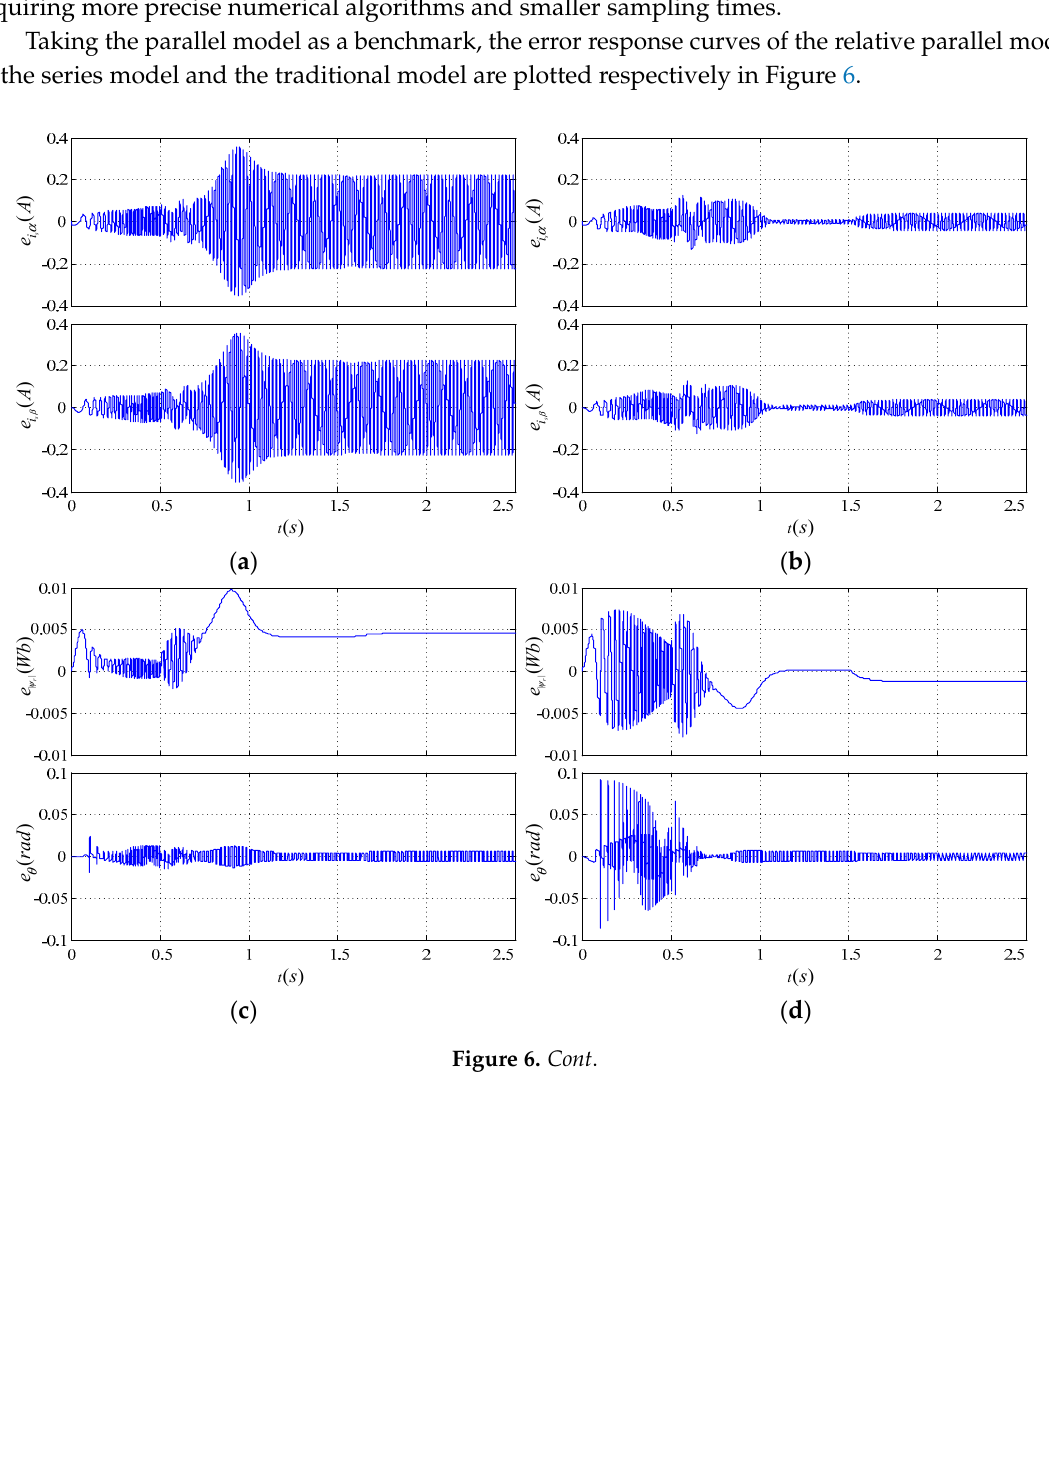
Figure 5. Response of parallel model under given conditions. ( a ) Stator voltage; ( b ) Stator current; ( c ) Magnetic flux amplitude; ( d ) ILS equivalent resistance; ( e ) Electromagnetic torque; ( f ) Speed.